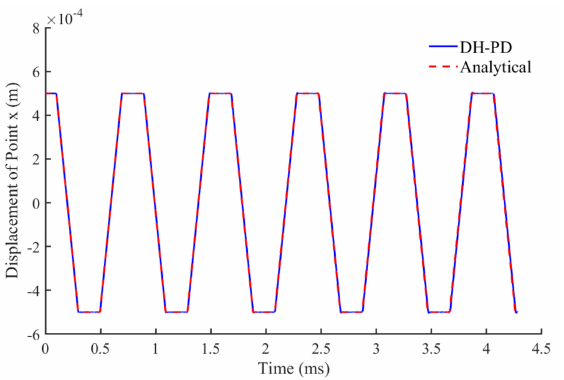
Figure 8. Variation of the displacement of the particle numbered 500 with time.